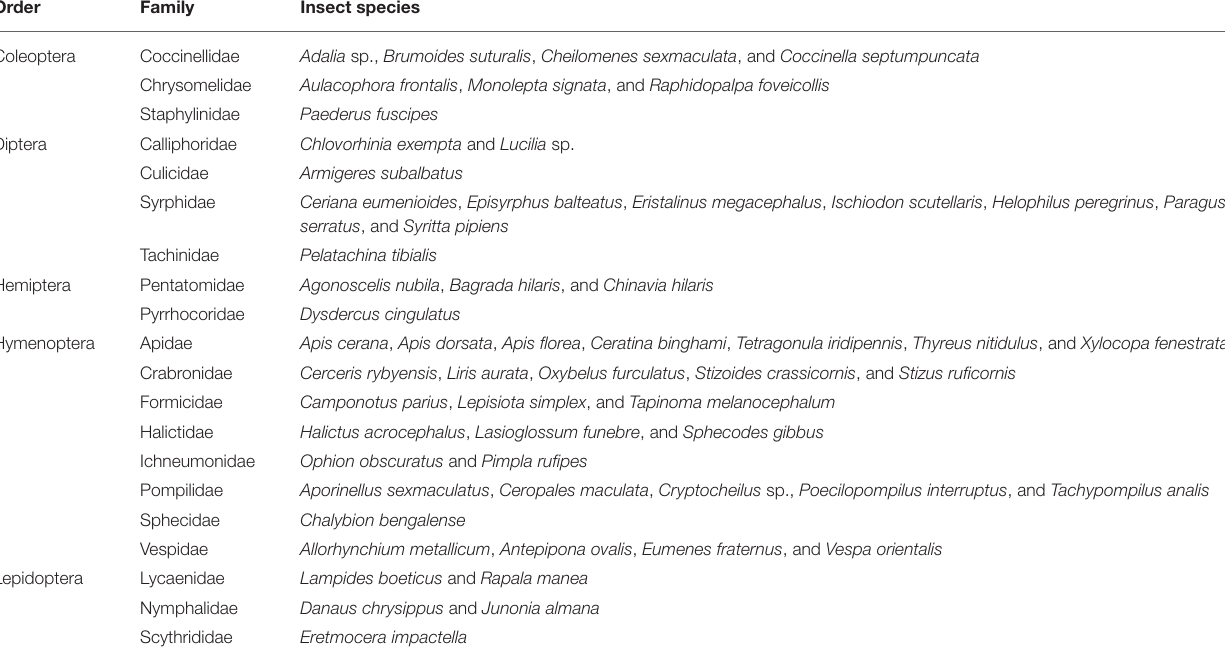
TABLE 2 | Native floral visitors of fennel in West Bengal, India.